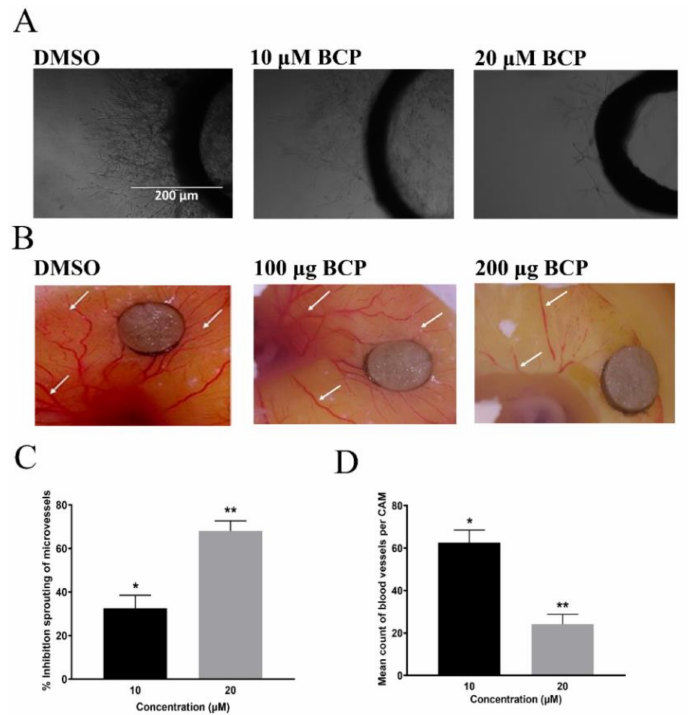
Figure 4. BCP inhibited angiogenesis ex vivo and in vivo. Photomicrographs showing the anti- angiogenic effect of BCP on the sprouting of microvessels in the rat aortic ring assay after treatment with (0.5% DMSO), 10, and 20 µ M BCP. Representative images were taken on the 5th day of the ex- periment using an inverted phase-contrast microscope at 4X magnifications with the scale indicating 200 µ m ( A ). Photomicrographs showing anti-angiogenic effect of BCP against chick embryonic CAM assay. Representative images of BCP on neovascularization in the chorioallantoic membrane, where the white arrows indicate the growth of new blood vessels indicating angiogenesis ( B ). Effect of BCP on rat aortic ring assay ( C ). Effect of BCP on the chick embryonic CAM assay ( D ). The data were represented as the mean ± SD ( n = 3). * p < 0.05 and ** p < 0.01 compared to DMSO-treated control